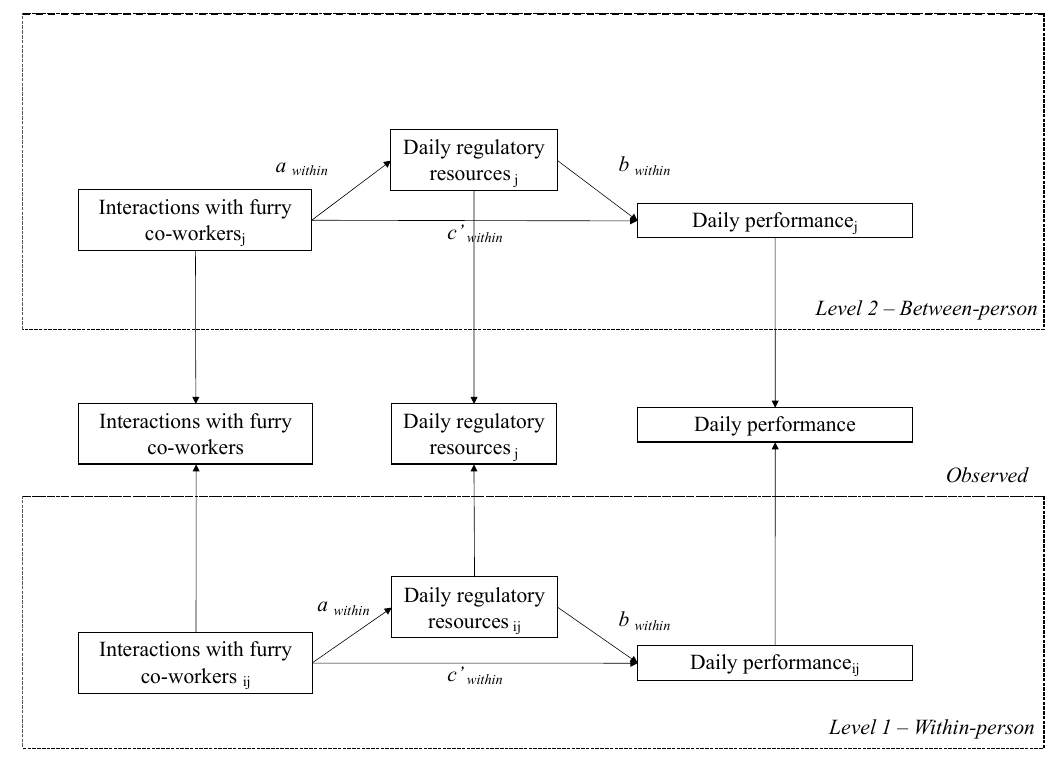
Figure 1. Conceptual model. For brevity, the control variables were not shown in the framework. Hypothesis 2: The relation between daily HAIs and daily (a) task and (b) adaptive performance will be mediated by daily regulatory resources.